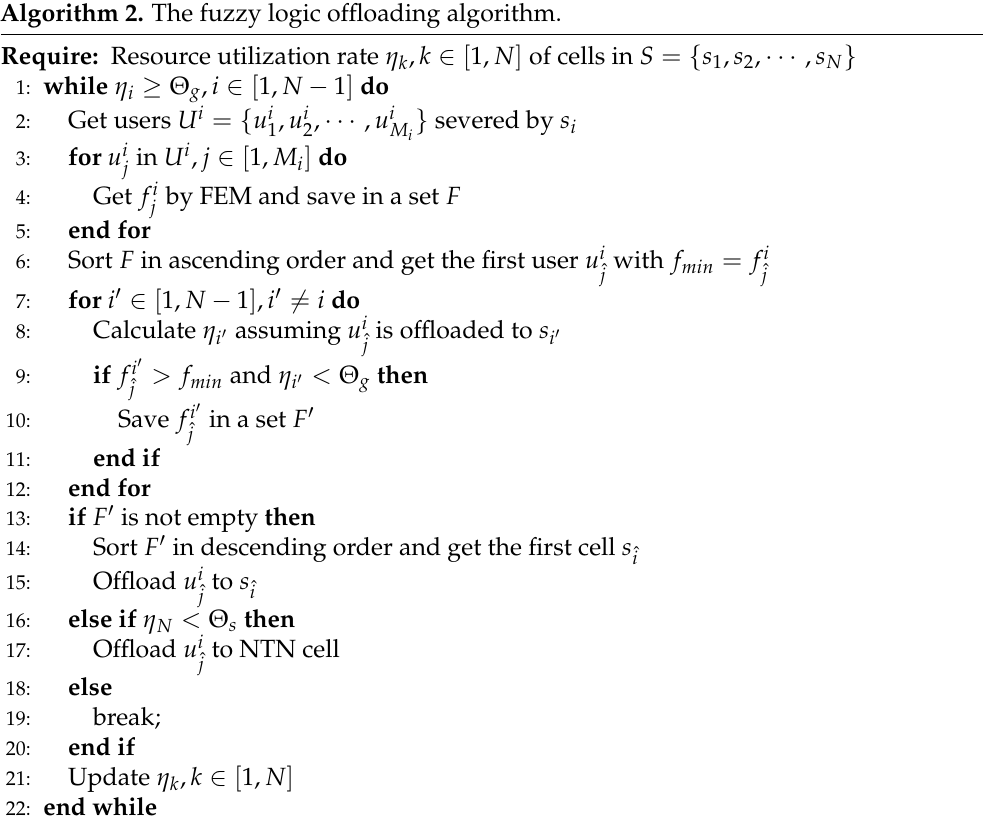
Algorithm 2. The fuzzy logic offloading